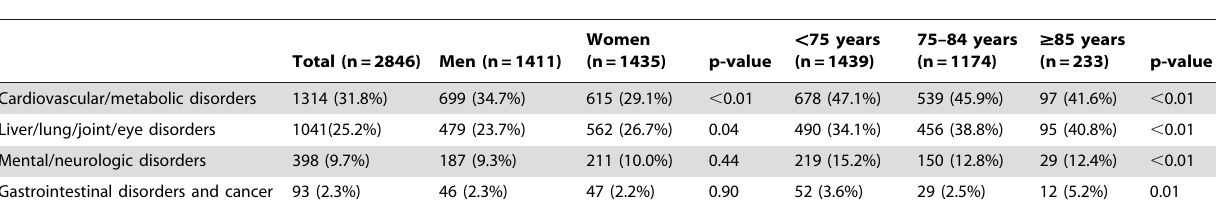
Table 5. Number and percent of persons who could be assigned to the multimorbidity